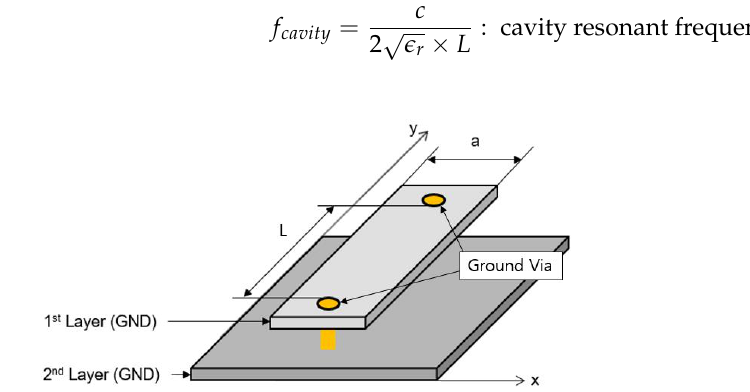
Figure 5. Conceptual diagram of signal transmission and reflection in case of impedance disconti- nuity.